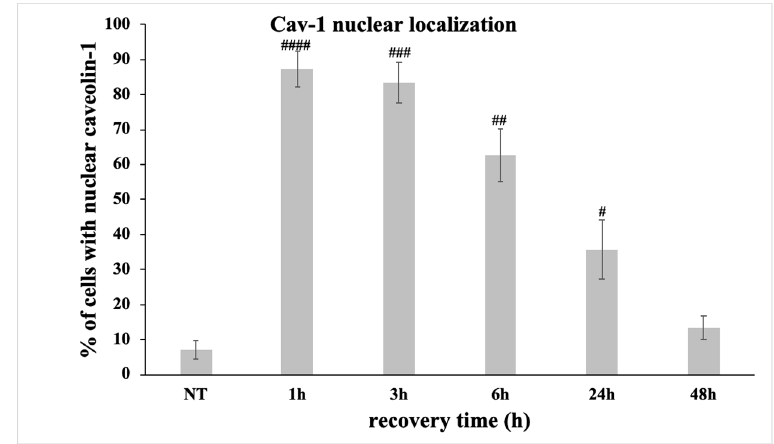
Figure 9. The percentage of control chondrocytes with nuclear caveolin-1 increased after oxidative insult and decreased back to basal levels for 48 h post-treatment. Percentages of control chondrocytes (three different control samples) with nuclear localization of caveolin-1 under normal conditions (No Treatment—NT) and at different time points of the recovery period from the oxidative treatment (1 h, 3 h, 6 h, 24 h, and 48 h). # p < 0.05, ## p < 0.01, and ### p < 0.001, #### p < 0.0001 versus NT. p values